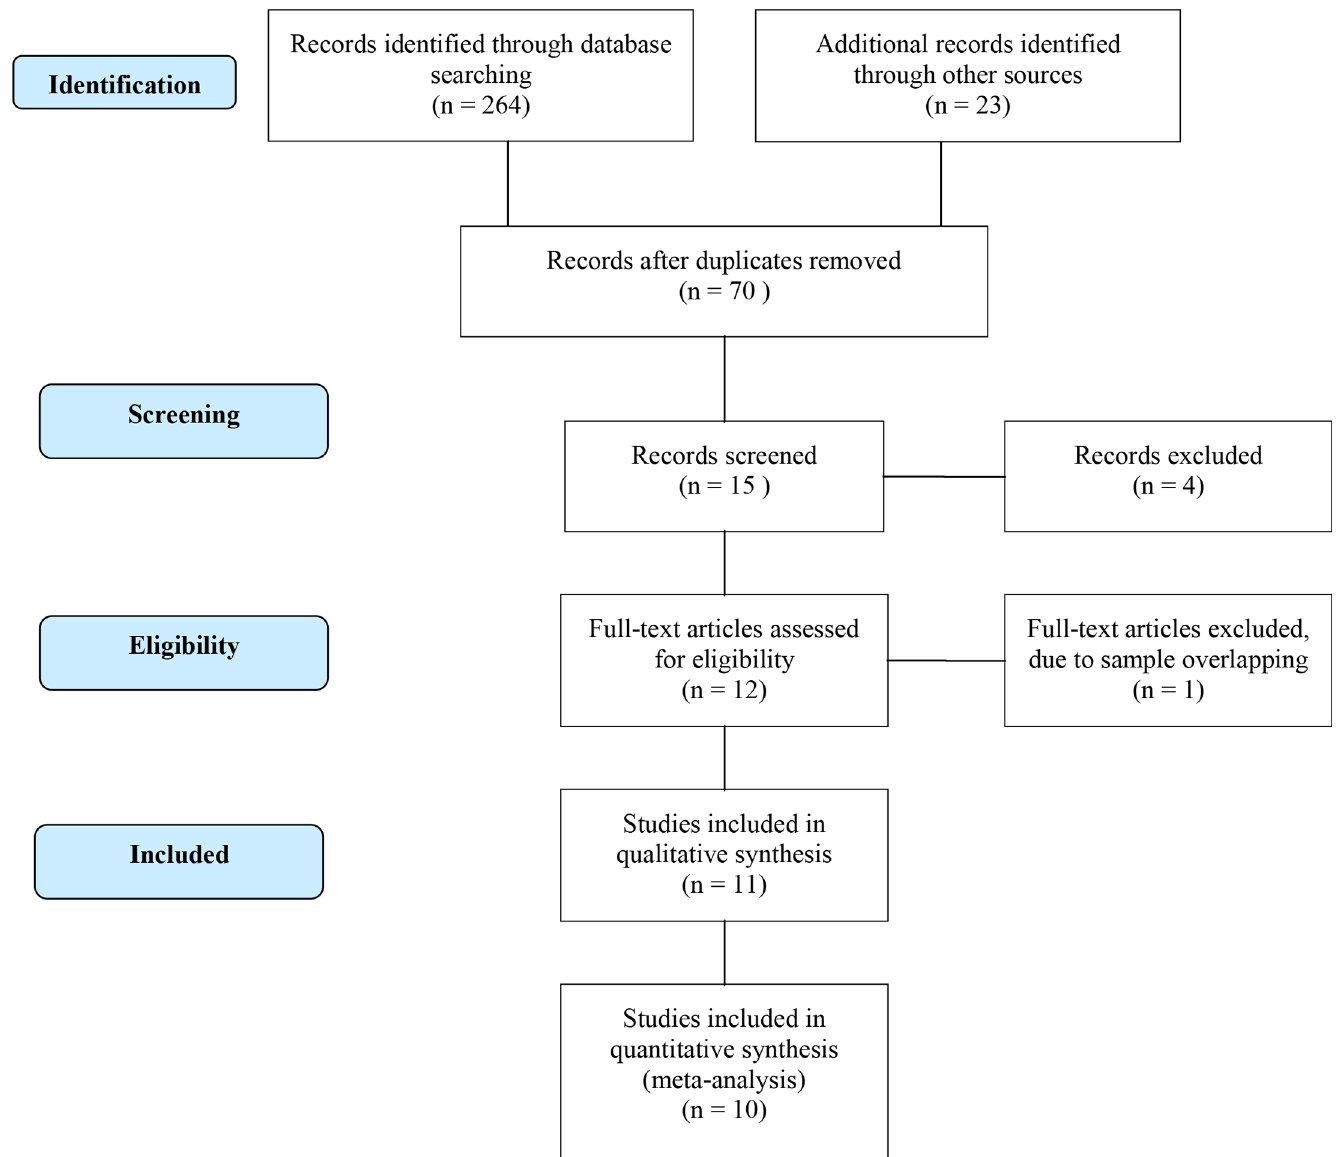
Fig 1. Flow diagram of the process of identification of eligible